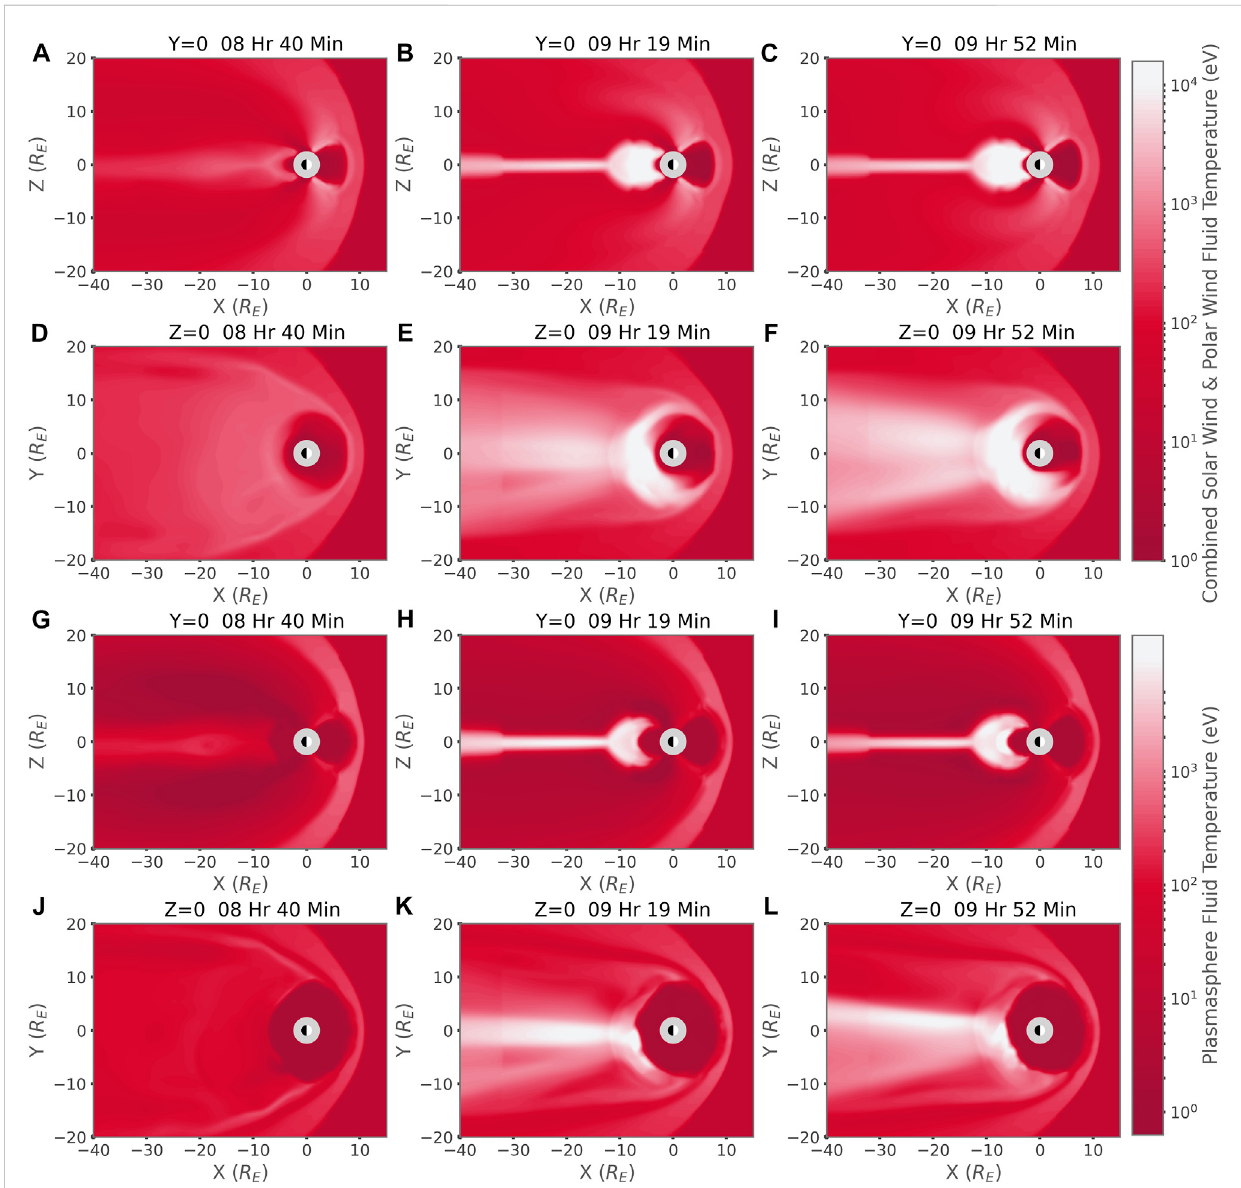
FIGURE 5 Temperature of Fluids in BATS-R-US for the Ideal Square Wave event. Column (A) : 8Hr and 40 Mininto the simulation. Column (B) : 9Hr 19 Mininto thesimulation.Column (C) :9Hr52Minintothesimulation. (A – F) Temperatureofthecombinedsolarwindandploarwind fl uid. (A – C) Y=0slices, (D – F) Z = 0 slices. (G – L) Temperature of the plasmasphere fl uid. (G – I) Y = 0 slices, (J – L) Z = 0